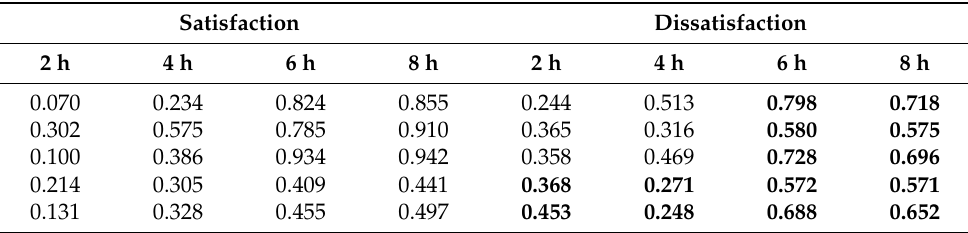
Table 7. Two cases of whether cumulative characteristic is satisfied in the cumulative dissolution profile for SRMT.